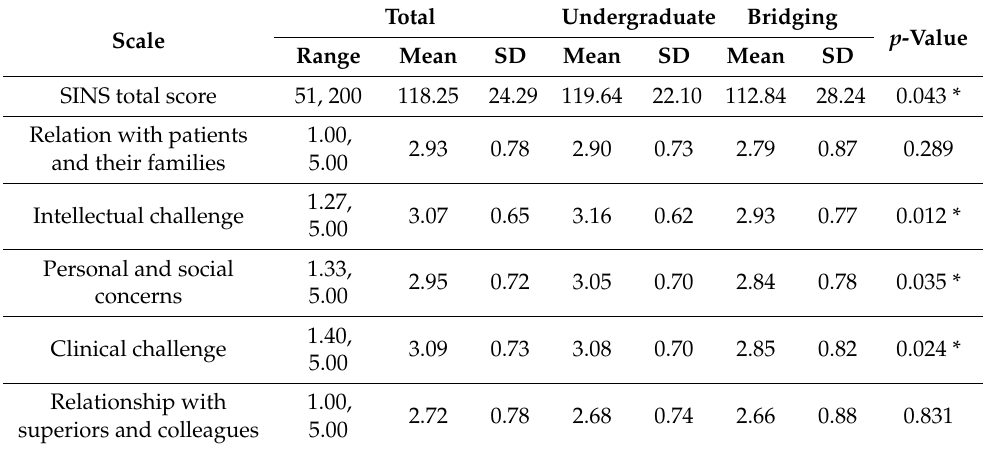
Table 3. Levels of stress among baccalaureate versus bridging nursing students (independent t